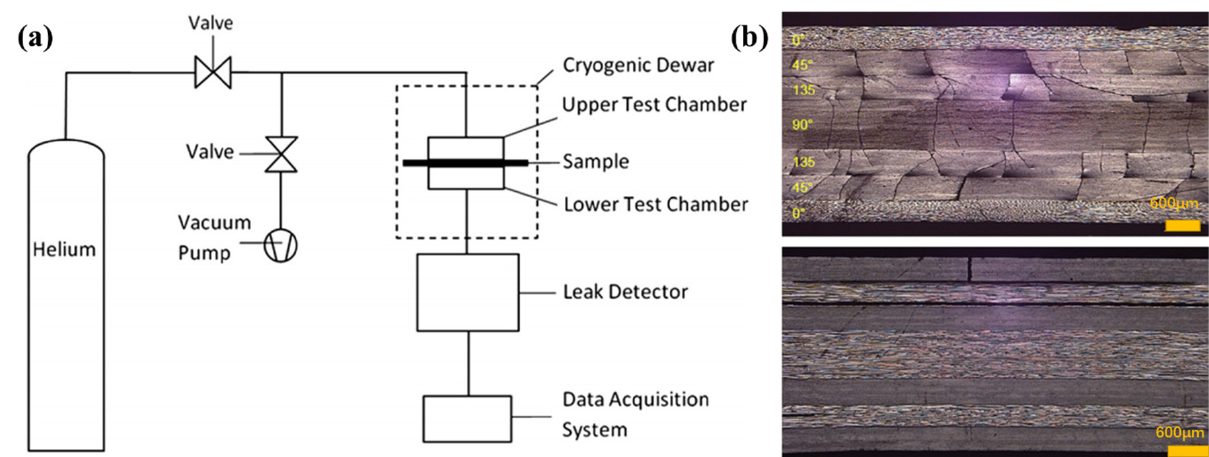
Figure 9. ( a ) Schematic of the test setup used for permeability testing of composites. Reused with permission from Ref. [125]. Copyright 2017 Elsevier. ( b ) Cryogenically induced high density microcracking and delaminations in quasi-isotropic laminate ( top ) and large-scale delamination and single microcrack in cross-ply laminate ( bottom ). Reused with permission from Ref. [126]. Copyright 2014 Elsevier.